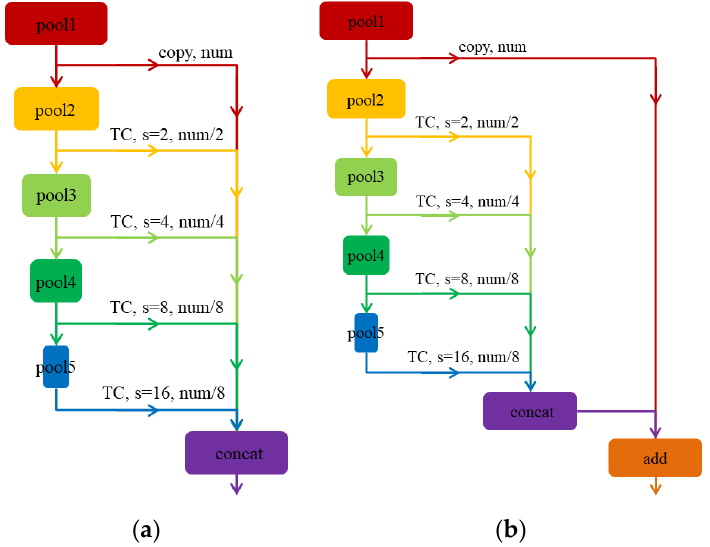
Figure 5. Feature fused methods. ( a ) Concatenate the features of TC results and skip connection. ( b ) Sum the features of TC results, then concatenate with skip connection.